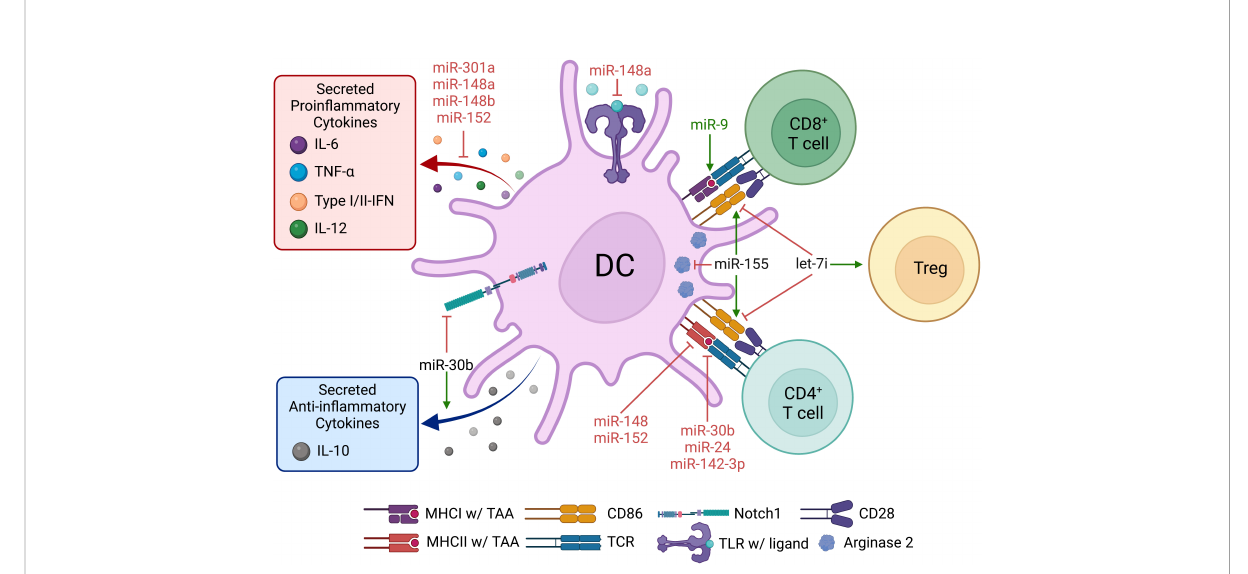
FIGURE 4 Dendritic cell miRNAs regulate pro- and anti-tumor immune responses in the TME. Dendritic cells are a central hub for priming pro- and anti- tumor immune responses in cancer. Many DC miRNAs change TAA presentation to and co-stimulation of T cells, required for T-cell – mediated anti-tumor immunity. Several other miRNAs suppress the proin fl ammatory functions and promote the immune suppressive function of